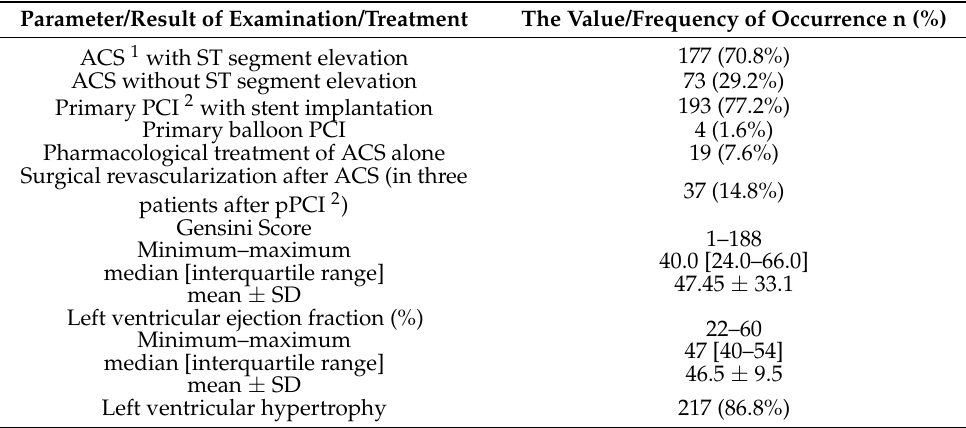
Table 4. Data related to the diagnosis and treatment of the acute coronary